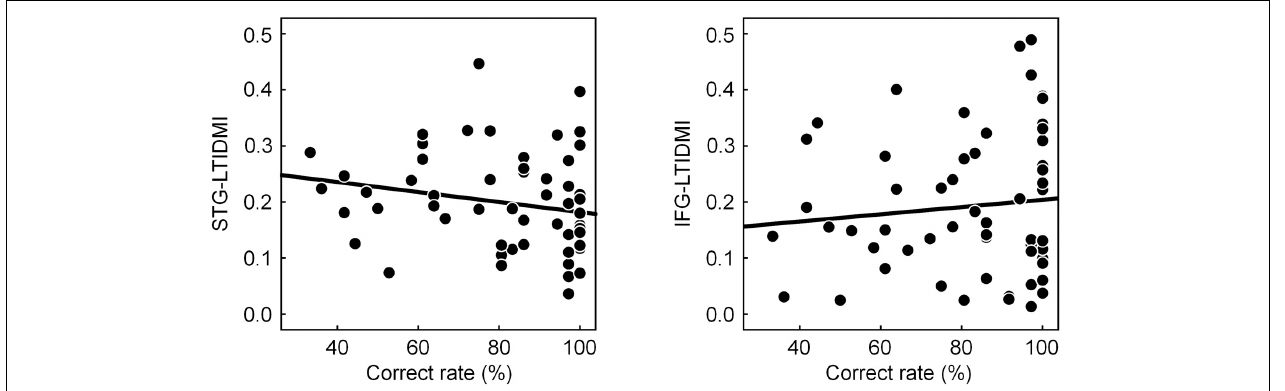
FIGURE 3 | Correlation between correct rate (CR) and STG-LTDMI/IFG-LTDMI. The CR was only negatively correlated with the STG-LTDMI ( n = 57, one-tailed Spearman’s rank correlation, Spearman’s ρ = − 0.260, and p = 0.026). However, for the IFG-LTDMI, a significant correlation was not observed in both all participants, and subgroups. Best-fit trend lines for all participants (black solid line) are depicted in each graph. CR, correct rate; STG, superior temporal gyrus; LTDMI, linearized time-delayed mutual information; IFG, inferior frontal